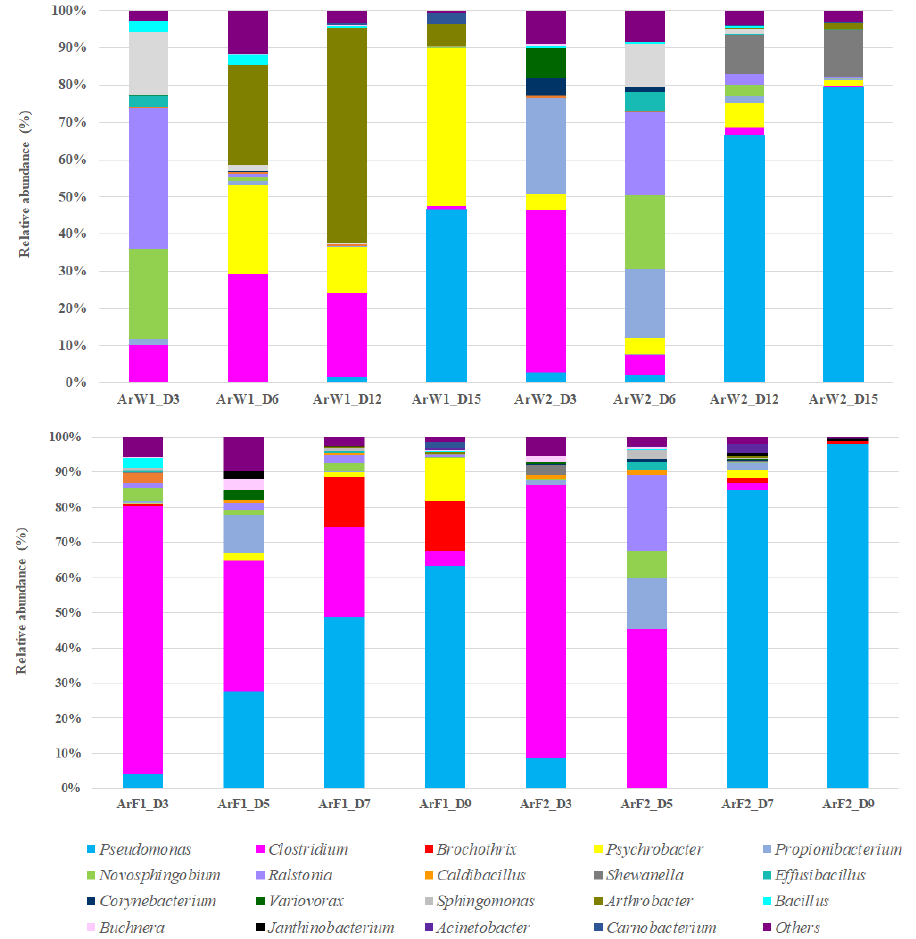
Figure 2. Relative abundance (%) of top-20 bacterial genera of whole (ArW) and filleted (ArF) chill- stored meagre caught in January (1) and July (2), obtained through metabarcoding analysis of 16S rRNA gene at intervals of storage